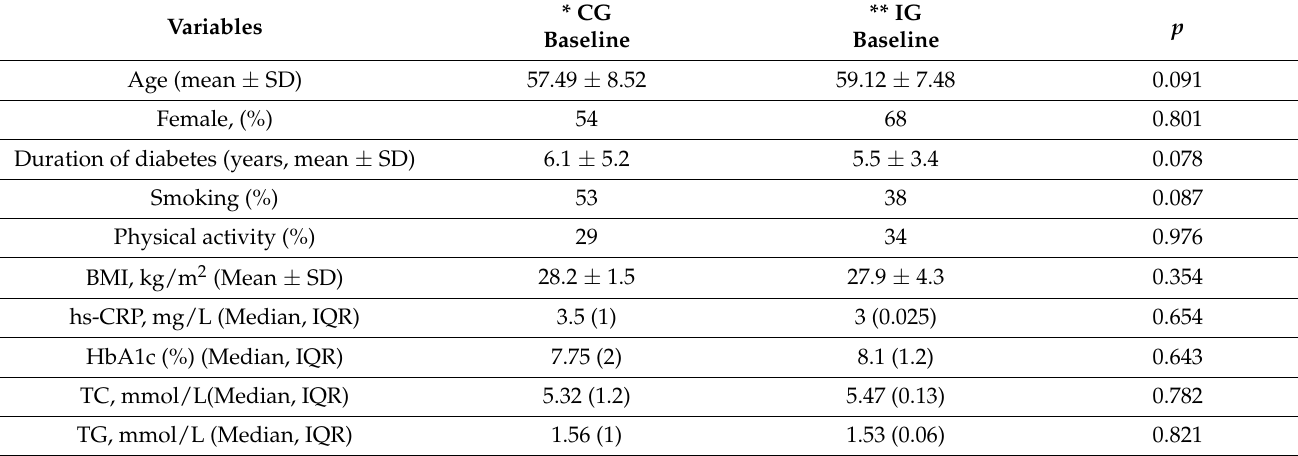
Table 1. Patient’s demographic and clinical characteristics at